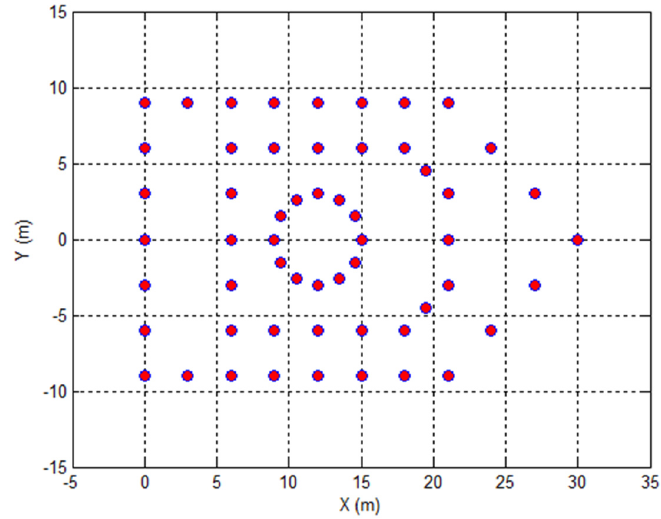
Figure 7. Scatterers model of a ship target.